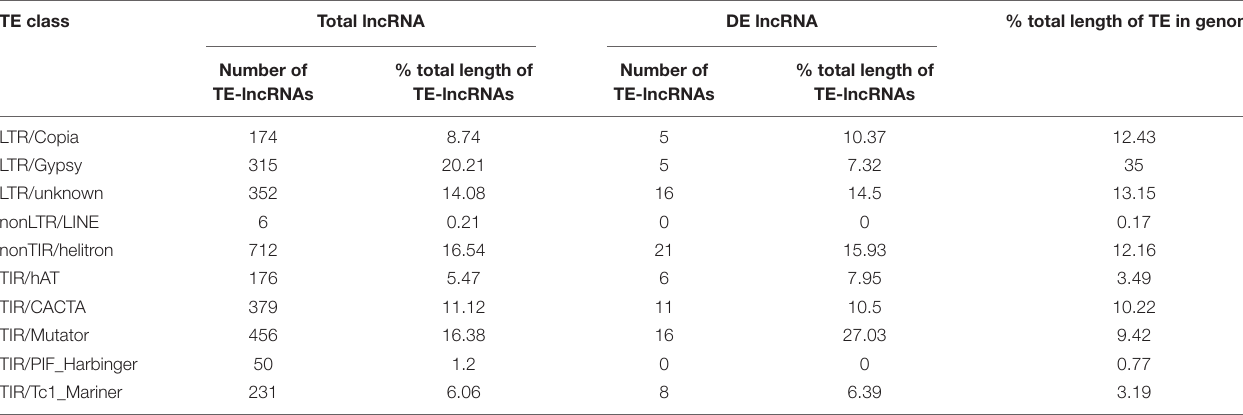
TABLE 3 | The contribution of different TE families to lncRNAs in quantity and